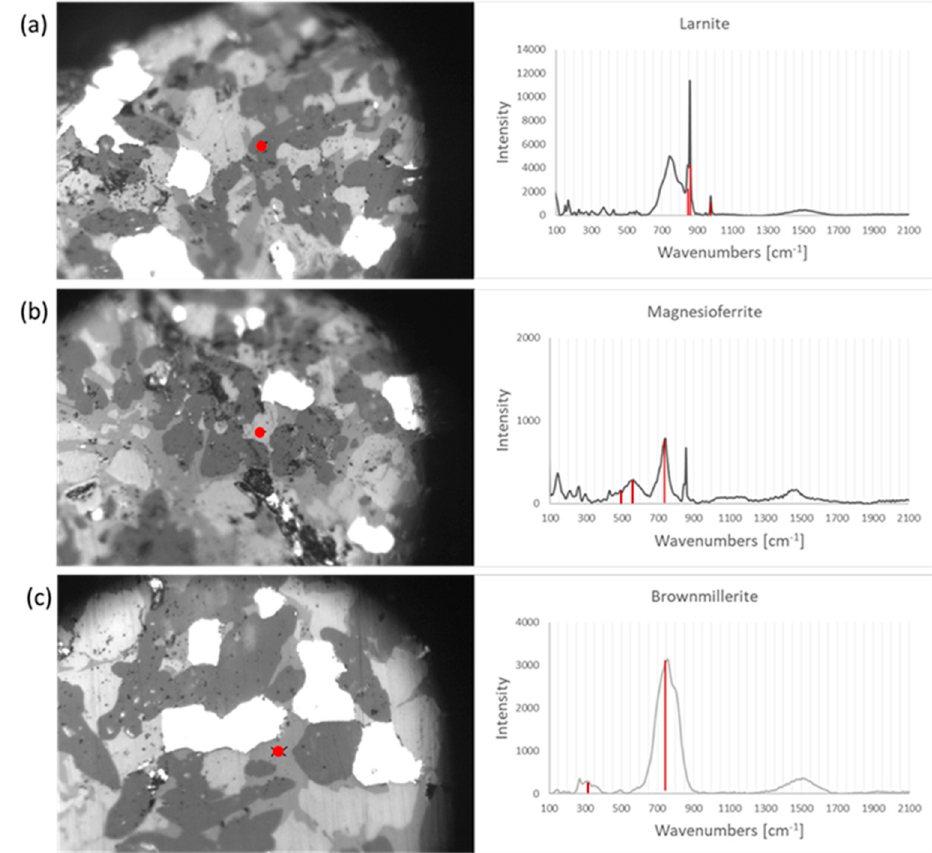
Figure 3. ( a – c ) µ-Raman images (50× objective) and spectra of identified phases in the three areas of sample A.